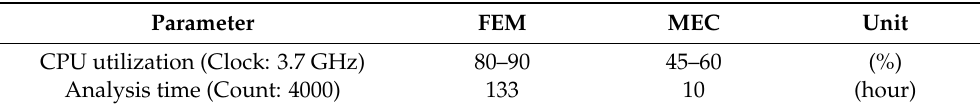
Table 4. Comparison of CPU utilization and analysis